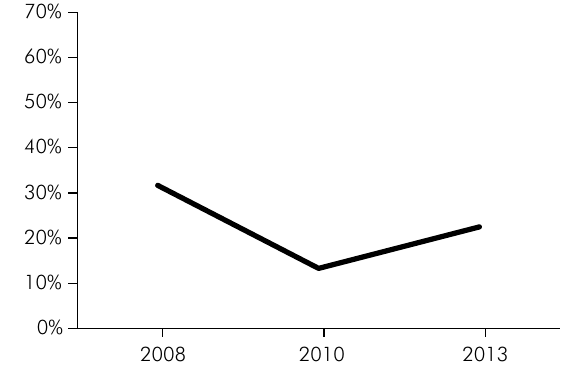
Figure 1. Trends in traumatic crown injuries prevalence between 2008 and 2013. Santa Maria, Brazil. p = 0.003 according to chi-square for trend